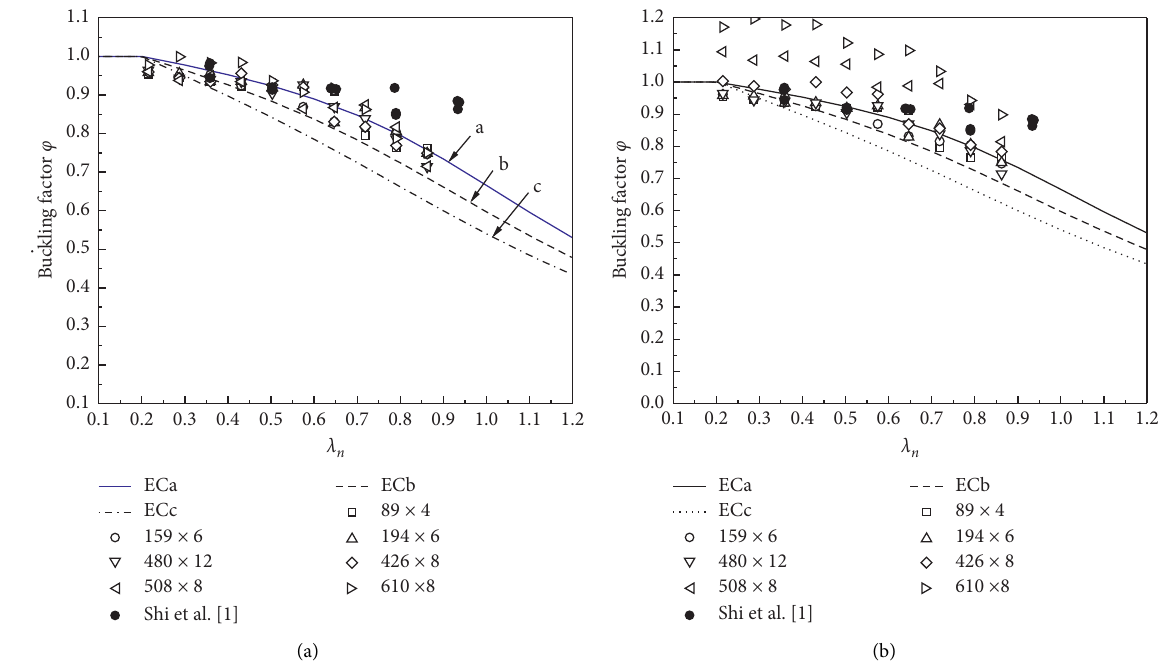
Figure 21: Comparison of FEM results with design curve Eurocode 3. (a) Excluding the local buckling effect with a provision in ASCE48-05. (b) Excluding the local buckling effect with a provision in AS4100.